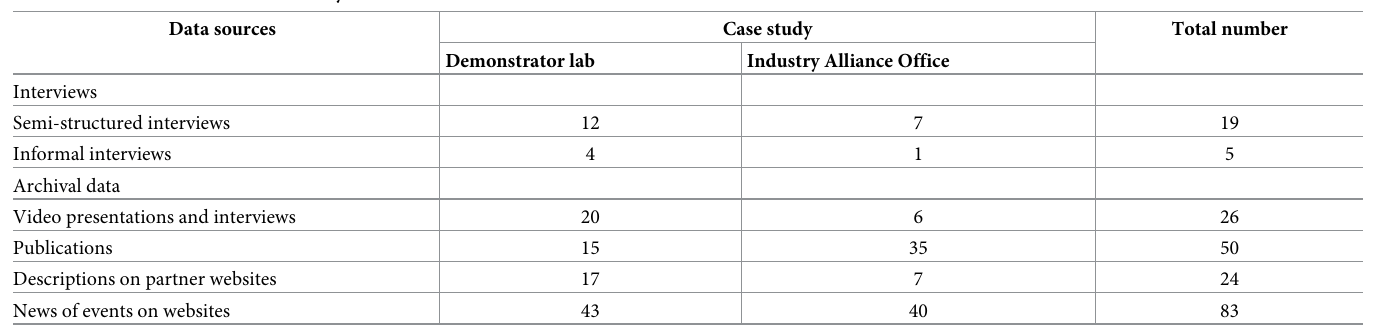
Table 2. Data sources of each case